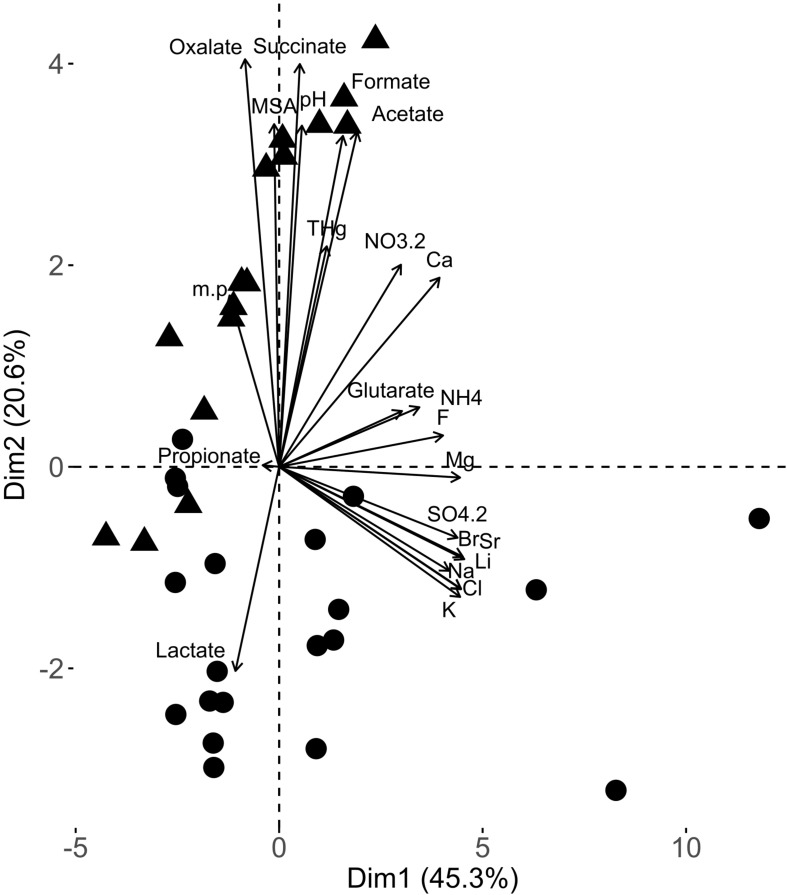
Principal component analysis biplot from the snow chemical analyses of the samples used in this study. The different chemical variables considered in this PCA are represented by vectors. The samples [black dots (early spring samples) and triangles (late spring samples)] are represented based on their respective projections.